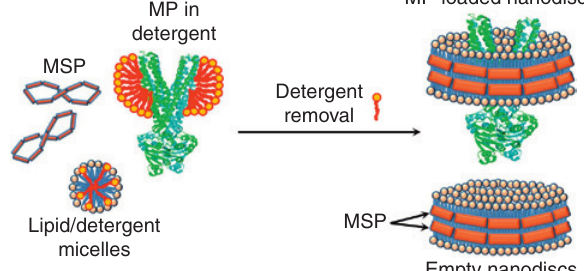
Figure 1: Assembly of nanodiscs. Schematic representation of the self-assembly of nanodiscs from a mixture containing an MSP, phospholipid/detergent mixed micelles (yellow circles: hydrophilic head; blue: phospholipid hydrophobic chains; orange circles: hydrophilic detergent moiety; red: hydrophobic detergent moiety) and detergent-solubilized MP upon detergent